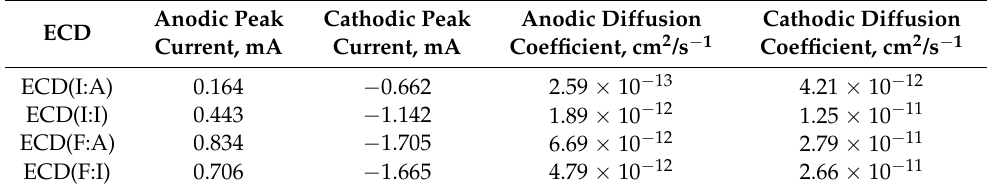
Table 1. Summary of the calculated diffusion coefficient values of the ECDs with various TCOs.